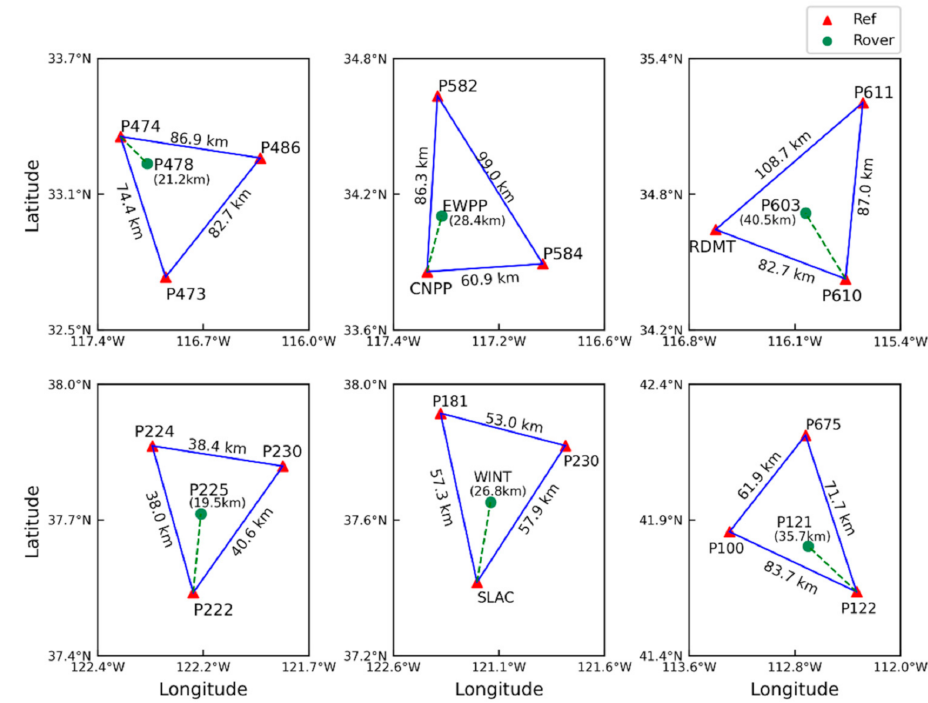
Figure 1. Geographical distribution of the selected stations in Dataset One.